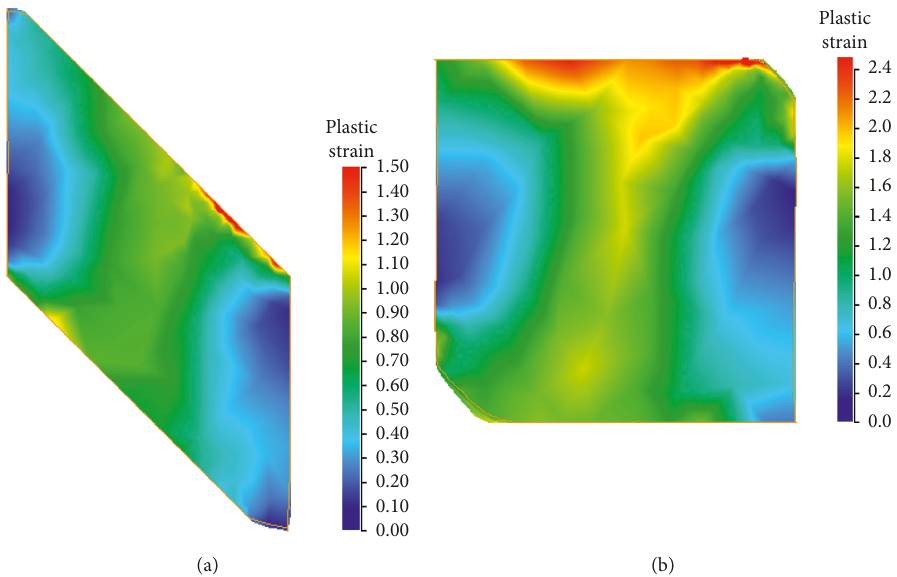
Figure 3: Diagram of the deformation of the workpiece cross section in the process of repetitive forging (RF) [31]: (a) after the first operation; (b) after the second